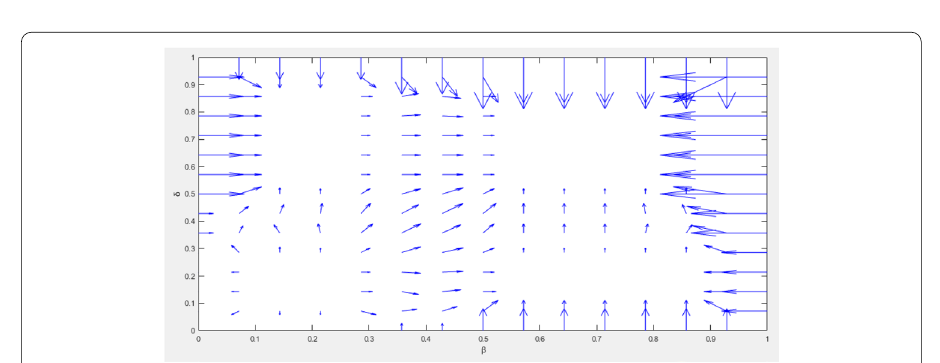
Fig. 11 Model dependency of δ and β on the security